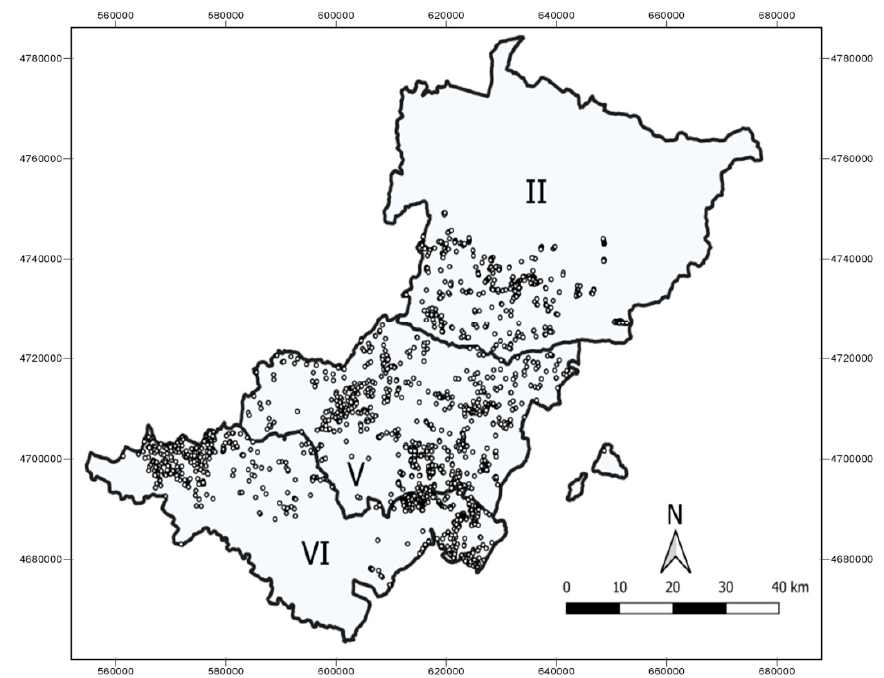
Figure 3. Three stratified areas corresponding to three agrarian zones, II in Montaña, V in media, and VI in Ribera Alta. The stratification for crop type classification and the corresponding training points. UTM coordinates are expressed in meters.